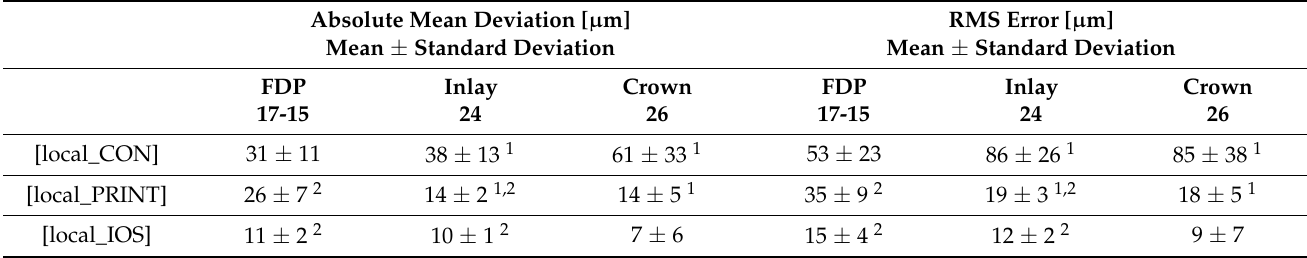
Table 3. Local Trueness values.